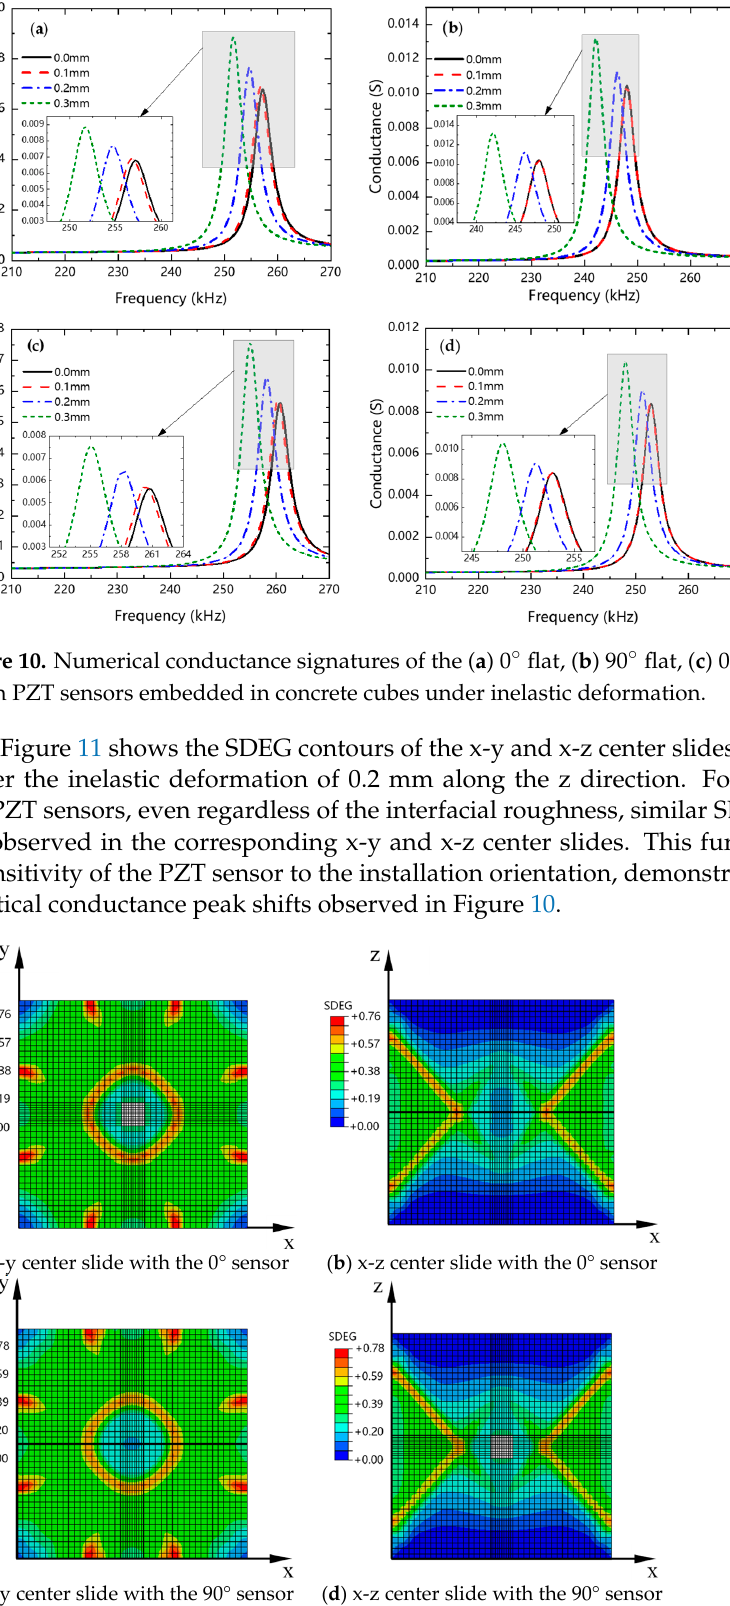
Figure 11. SDEG contours of the x-y and y-z center slides with 0° and 90° PZT sensors embedded in concrete cubes under the inelastic deformation of 0.2 mm.